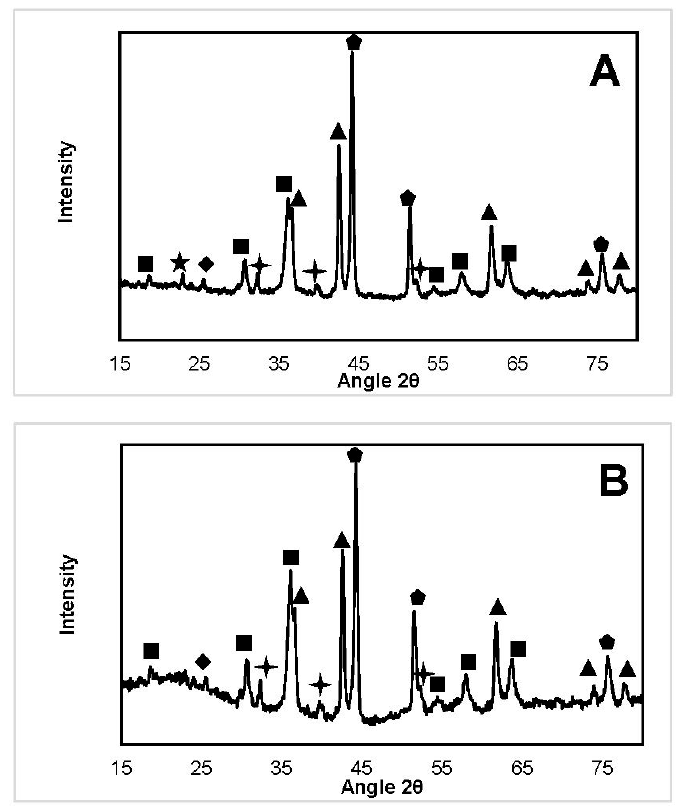
Figure 12. XRD spectra of Ni-UGSO after bio-oil WU SR at 800 °C: ( A ) WHSV = 1.8 g/g cat /h; and ( B ) WHSV = 7.1 g/g cat /h.